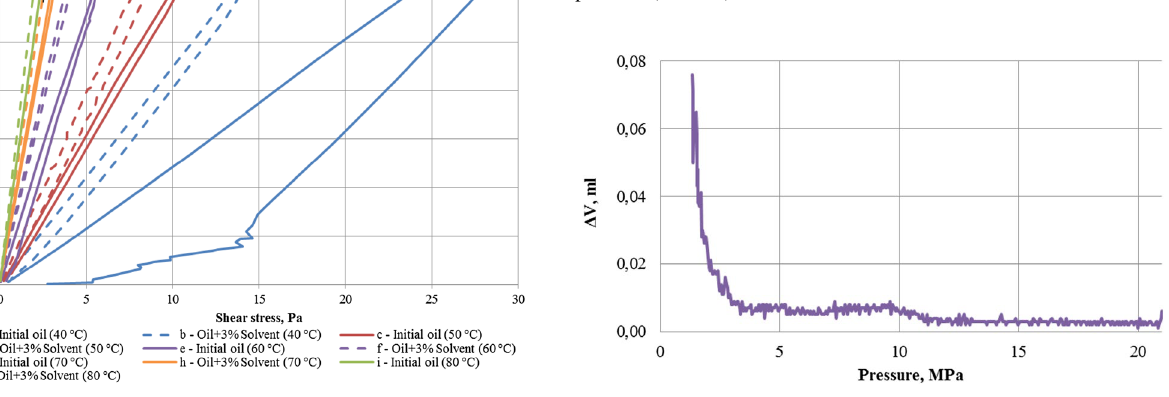
Fig. 9 Effect of temperature on light transmittance power at reservoir pressure (21 MPa)